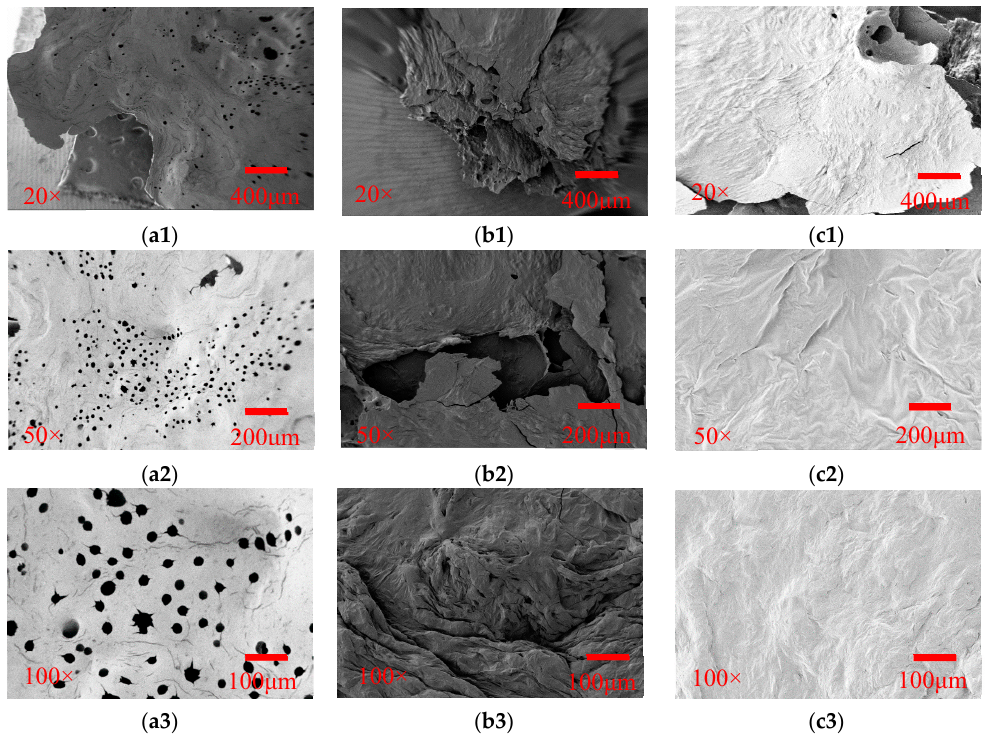
Figure 8. Digital and SEM images of the residues after cone calorimeter tests: ( a ) Sample 2; ( b ) Sample 7; and ( c ) Sample 8. Numbers 0–3 represent digital images and those at 20×, 50×, and 100× magnification, respectively.